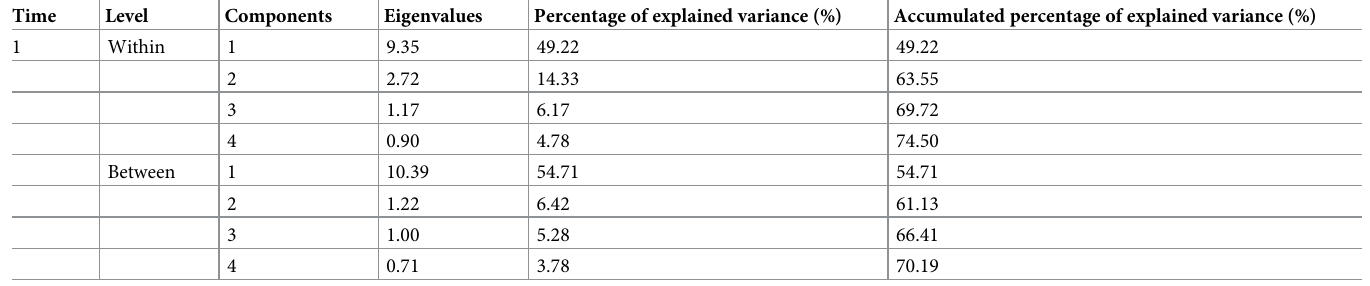
Table 4. Eigenvalues, percentage of explained variance (%) and accumulated percentage of explained variance for within and between sample correction matrix for 19 items at Time 1. Time